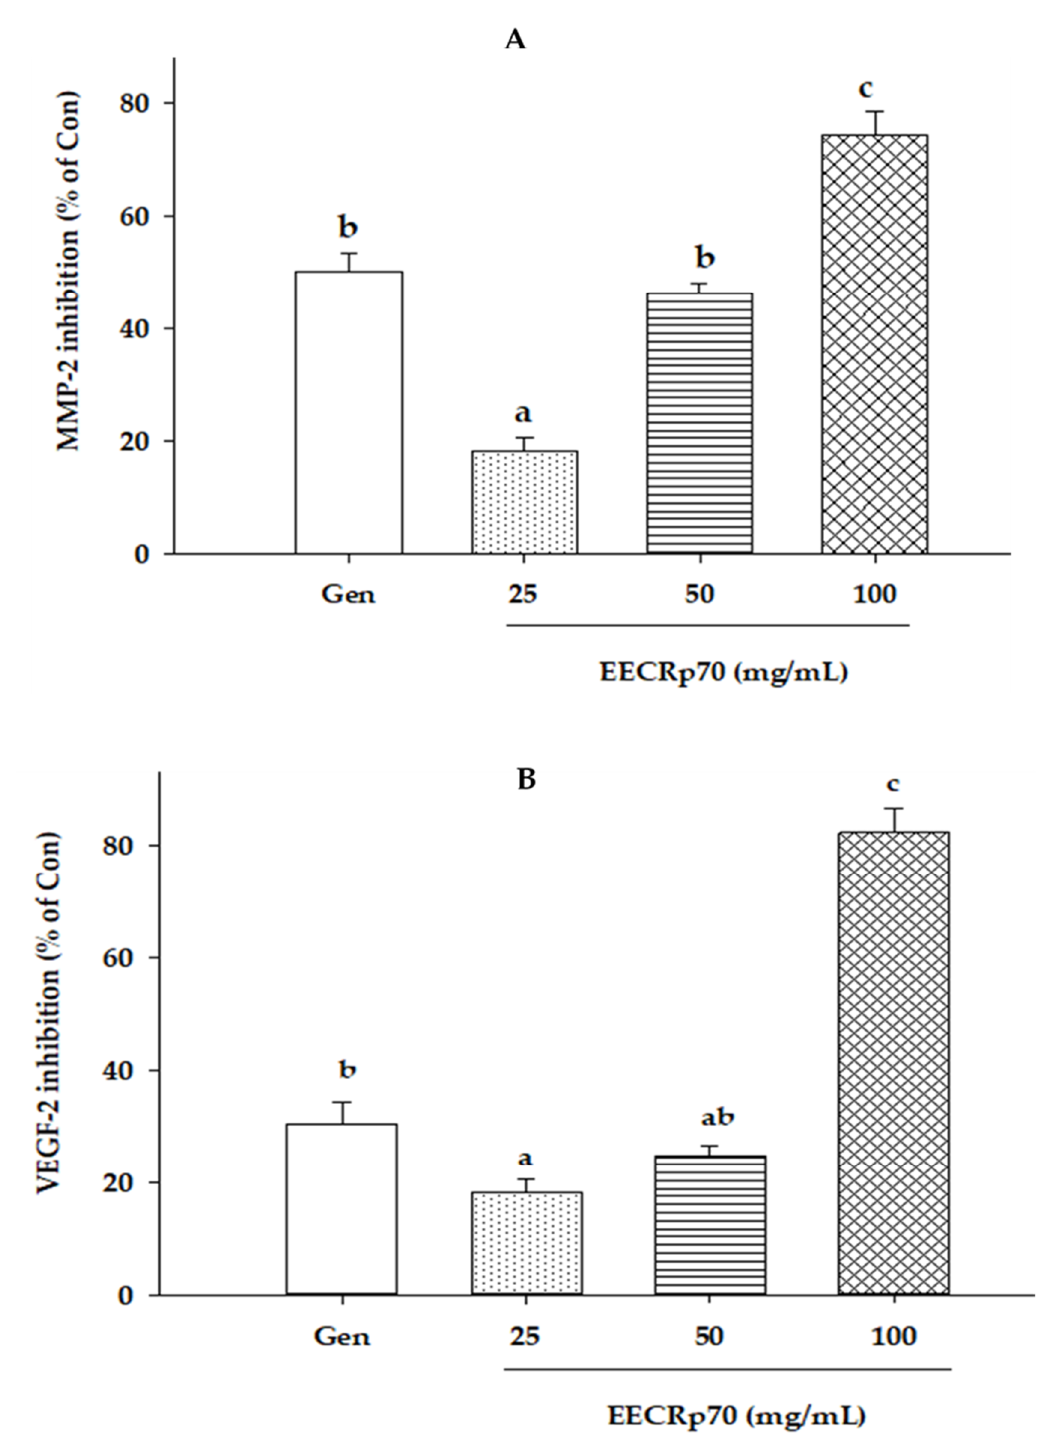
Figure 5. Effect of EECRp70 on the levels of ( A ) matrix metalloproteinase-2 (MMP-2) and ( B ) vascular endothelial growth factor-2 (VEGF-2) in SCC25 cells. Cells were treated with 25–100 µg/mL EECRp70 and 25 µM genistein for 24 h. The levels of MMP-2 and VEGF-2 released into the incubation medium were determined using an ELISA kit. Values (mean ± SD) that do not share a common letter are significantly different ( p < 0.05).